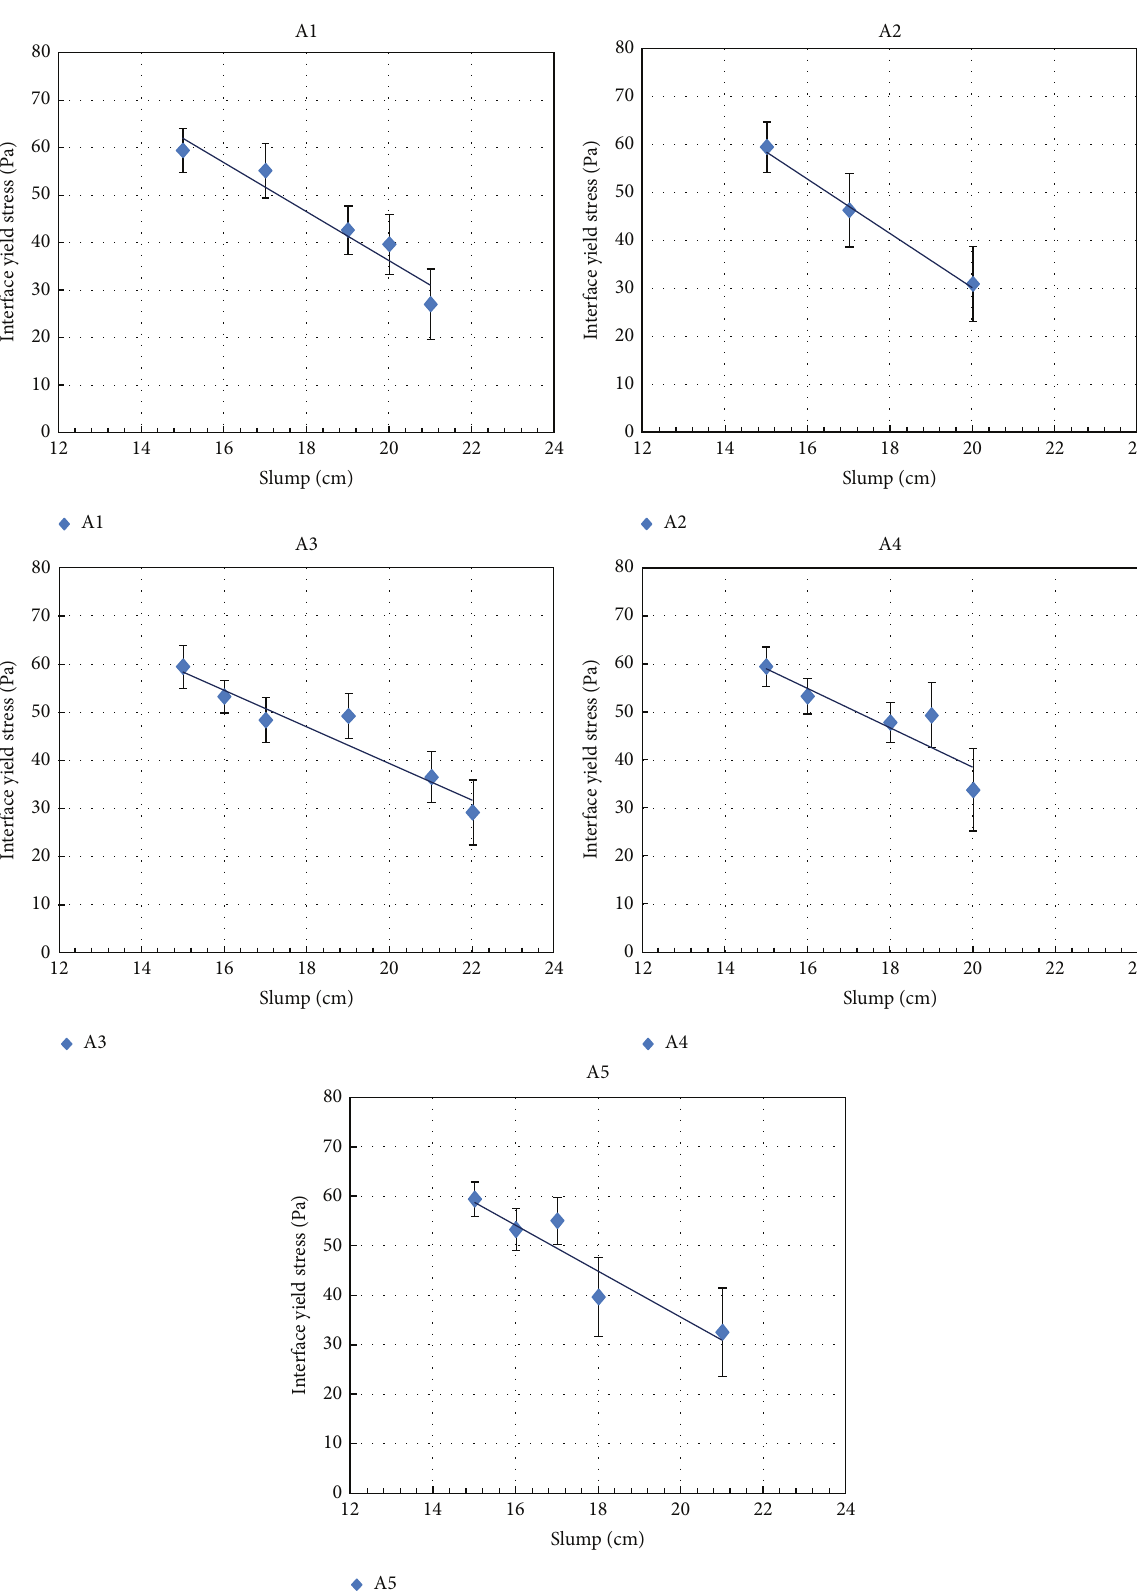
Figure 8: Experimental results of the second test